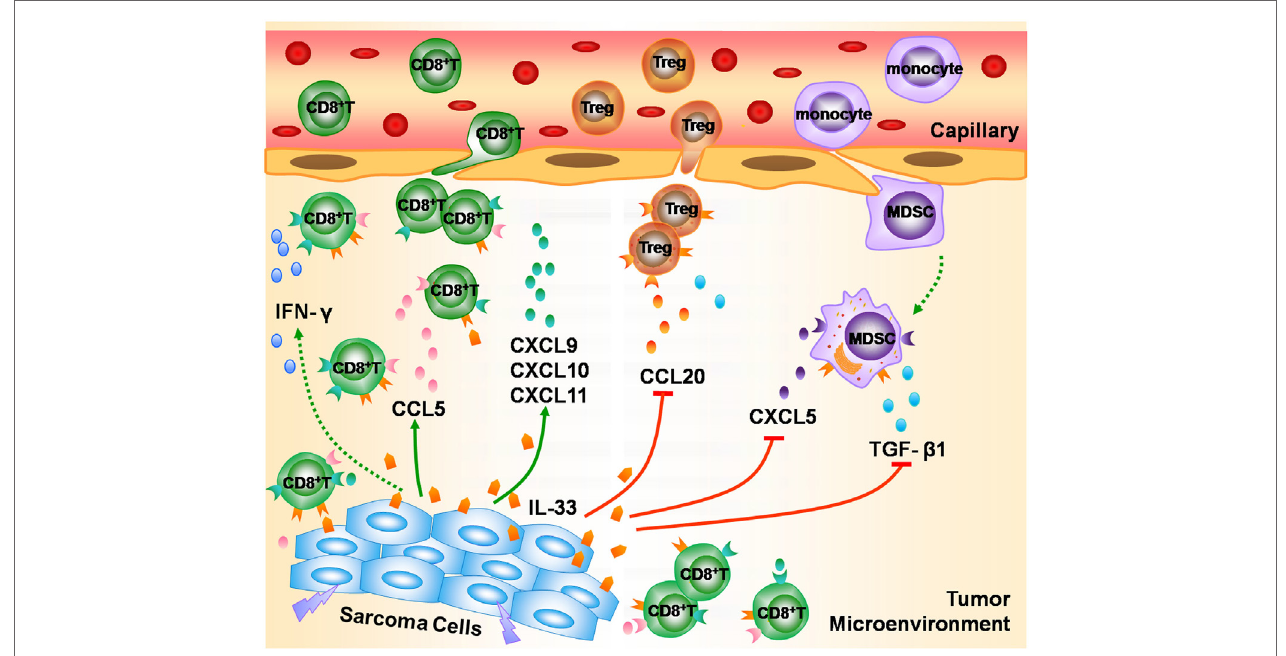
FigUre 6 | The possible role of the IL-33/ST2 axis in modulating antitumor immunity in soft tissue sarcoma (STS). During the development of STS, IL-33 is released from damaged or dead sarcoma cells into the tumor microenvironment, and enhances the recruitment of CD8 + T cells into tumor lesion by promoting the release of multiple chemokines such as CCL5, CXCL9, CXCL10, and CXCL11, and promotes CD8 + T cells to produce IFN- γ , thereby playing an important role in the modulation of antitumor immunity in STS. Meanwhile, IL-33/ST2 axis reduces the infiltration of Tregs and myeloid-derived suppressor cells via inhibiting the production of chemokines CCL20 and CXCL5, and suppresses the secretion of TGF- β 1, and thus contributes to antagonizing the immunosuppression in